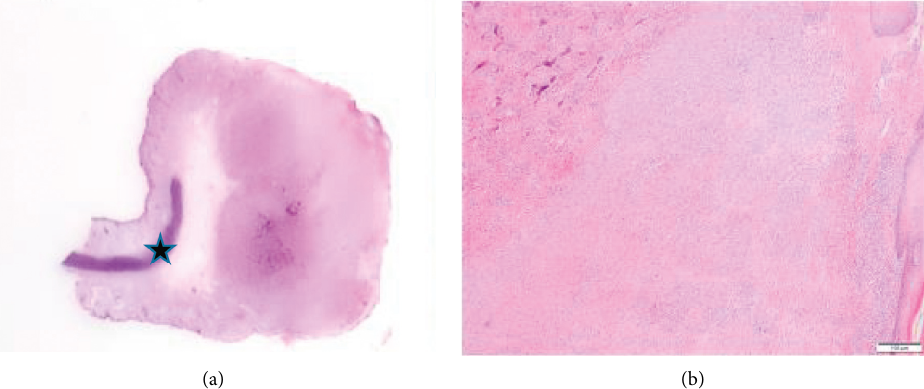
Figure 1: Auricular tumour node with an ulcerated surface that infiltrates the dermis while preserving cartilage ( ∗ ) (a). Transition from differentiated component with smooth muscle morphology to osteosarcoma component (b).